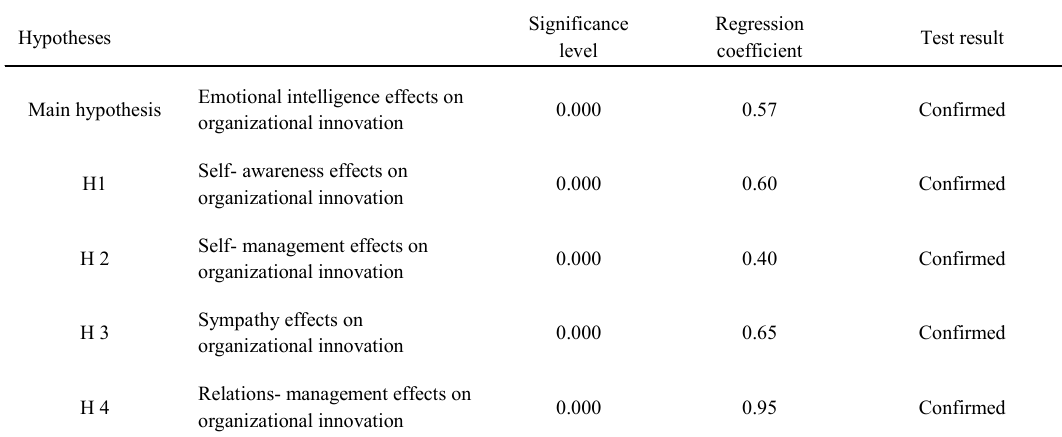
Table 5: Results of regression